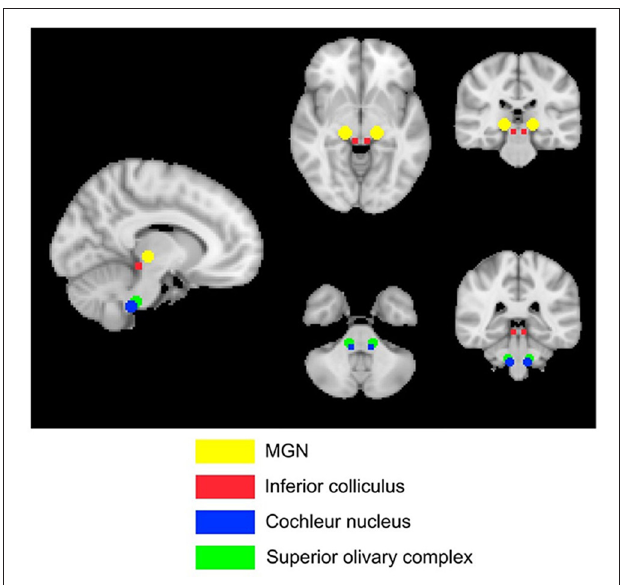
FIGURE 3 | The Mulhau masks that have previously shown anatomical changes relating to tinnitus.